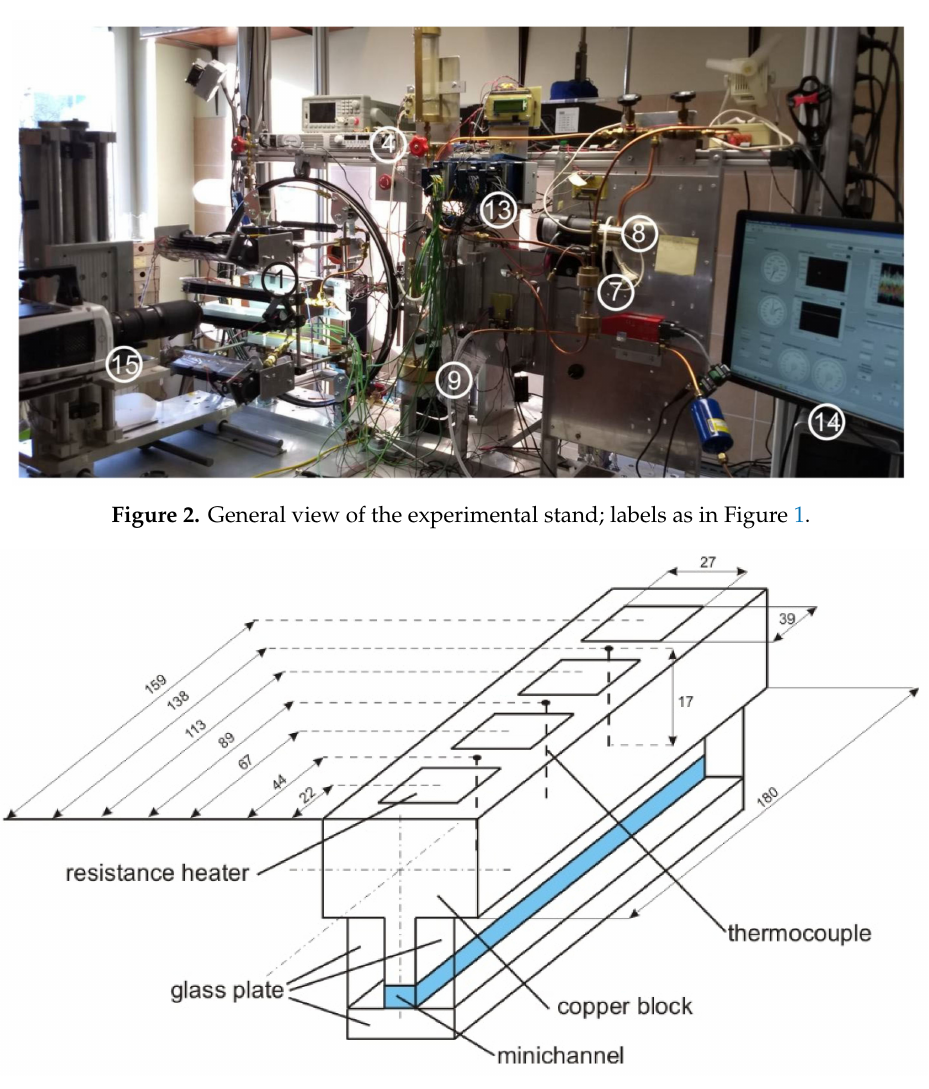
Figure 3. Copper block with attached glass minichannel and location scheme of resistance heaters and thermocouples—Transverse section and axonometric view; dimensions in mm (pictorial view, not to